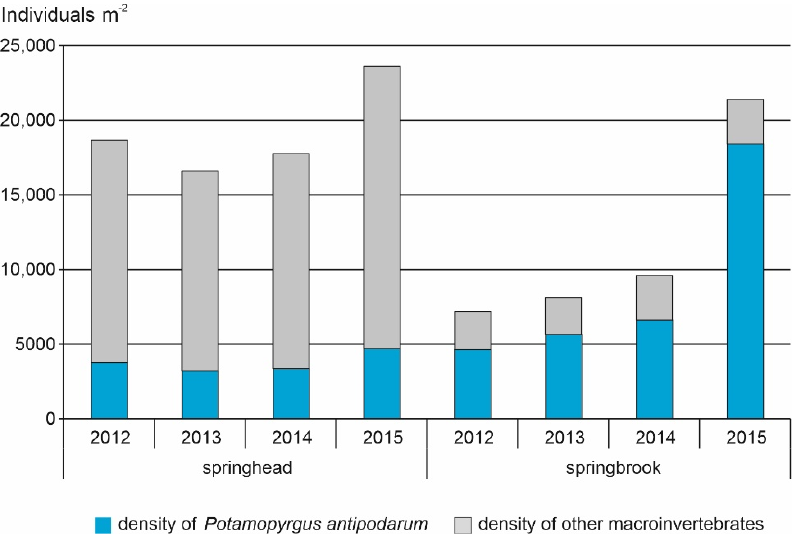
Figure 2. Density of Potamopyrgus antipodarum and other macroinvertebrates at the sampling areas during the study period.